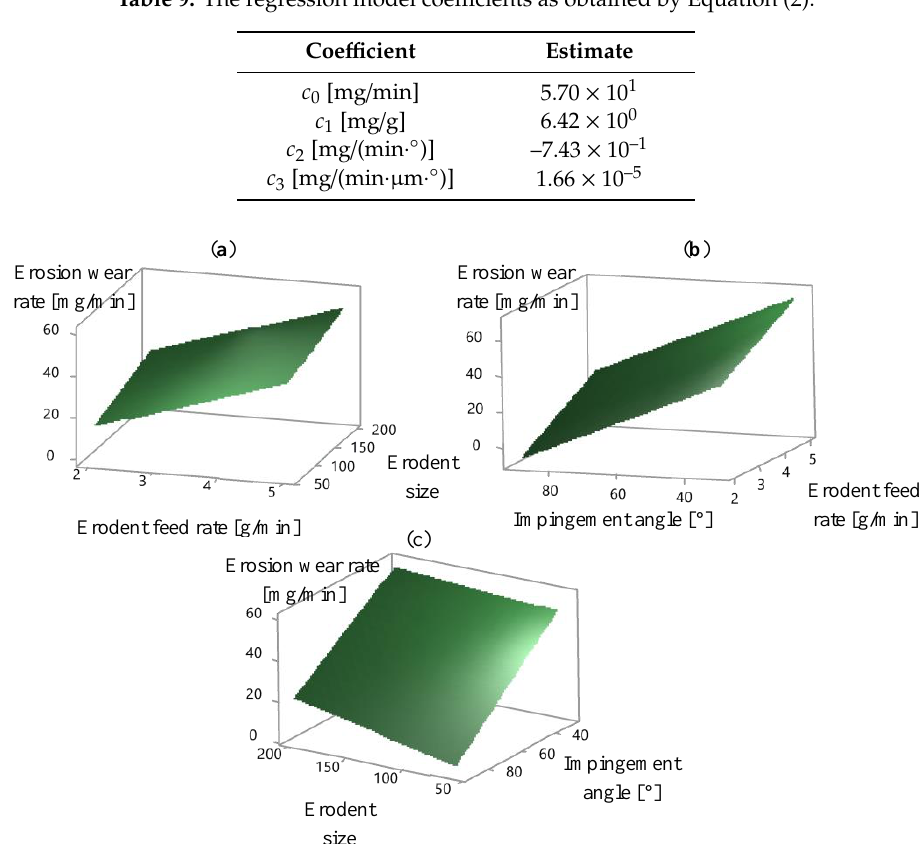
Figure 7. Surface plot of Erosion rate [mg/min] versus: ( a ) erodent feed rate [g/min] and size [µm] (impingement angle is set to 60°); ( b ) Impingement angle [°] and erodent feed rate [g/min] (erodent size is set to 90 µm); ( c ) erodent size [µm] and impingement angle [°] (Erodent feed rate is set to 3.5 g/min).